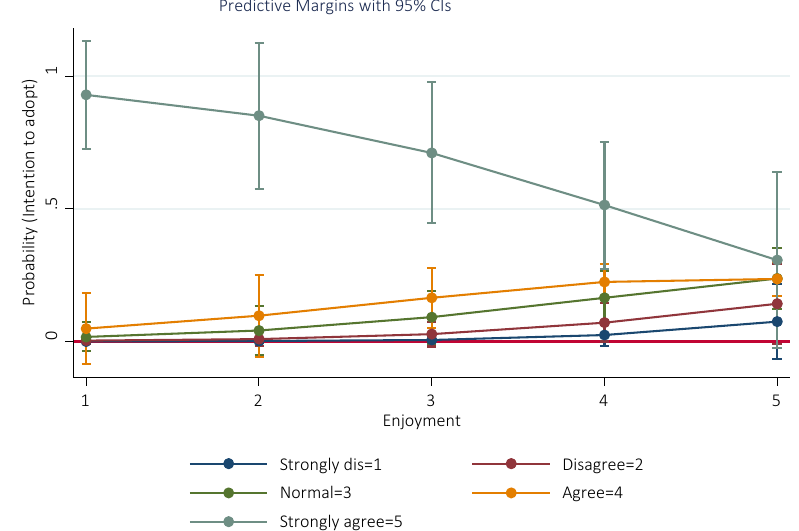
Figure 2. Marginal effects of interaction between economic benefit and enjoyment on the probability of intention to join the gig economy (in the